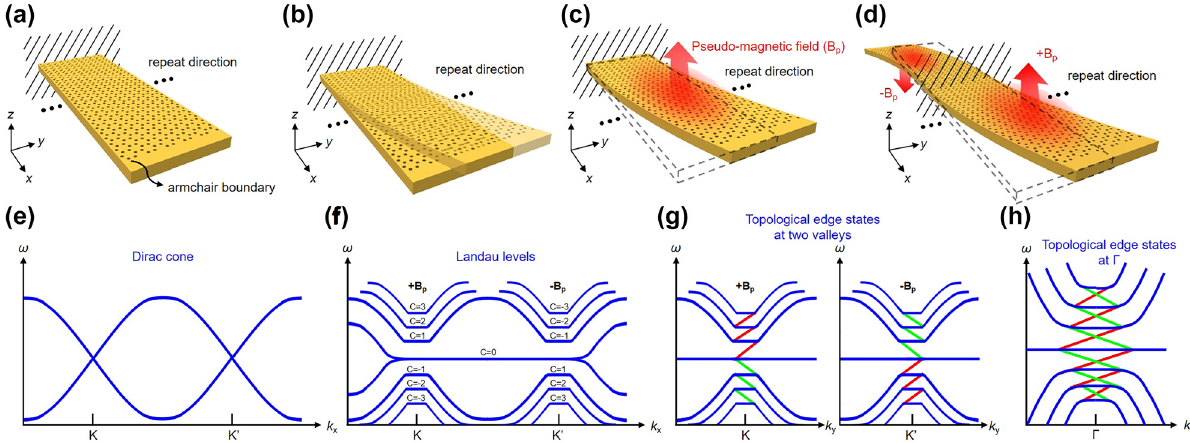
Figure 1: The schematic diagrams of deformation processes of a membrane containing honeycomb superlattice. (a) Before applying the strain constituted by shifting the lattice arrangement, a membrane with a honeycomb lattice is fixed like a cantilever beam. (b)After applying thestrain, the membraneis deformedalongthe y -axiswith oneend fi xed.(c) A synthetic vectorpotentialis produced by the continuously distributed strain, and its curl can de fi ne a pseudo-magnetic fi eld B p . (d) A chiral structure, which is composed of two patternswithoppositepseudo-magnetic fi elds.(e)Thebanddiagramofthemembranebeforeapplyingthestrain,andtwoDiracconesexistat theKandK ′ valley.(f)Afterapplyingthestrain,bandssplitintoseveralLandaulevels,andalocalbandgapappearsinthebanddiagram.Also, the corresponding valley Chern numbers ( C ) are indicated in this fi gure, and the central fl at band represents the 0th photonic Landau level. (g) The band diagram of the chiral structure. After the combination of two patterns with opposite pseudo-magnetic fi elds, topological edge statesappearbetweeneachLandaulevelattheKandK ′ valley,wheretheredandgreensolidlinesareindicatedasthespin-upandspin-down edgestates,respectively,andthephotonspinisde fi nedbythedirectionofthecircularpolarization.(h)TopologicaledgestatesattheKandK ′ valleyaresimultaneouslyprojectedtothe Γ pointbasedonBloch ’ sbandtheorybecausethedirectionoflatticearrangementalongthe x -axisof the membrane is along the